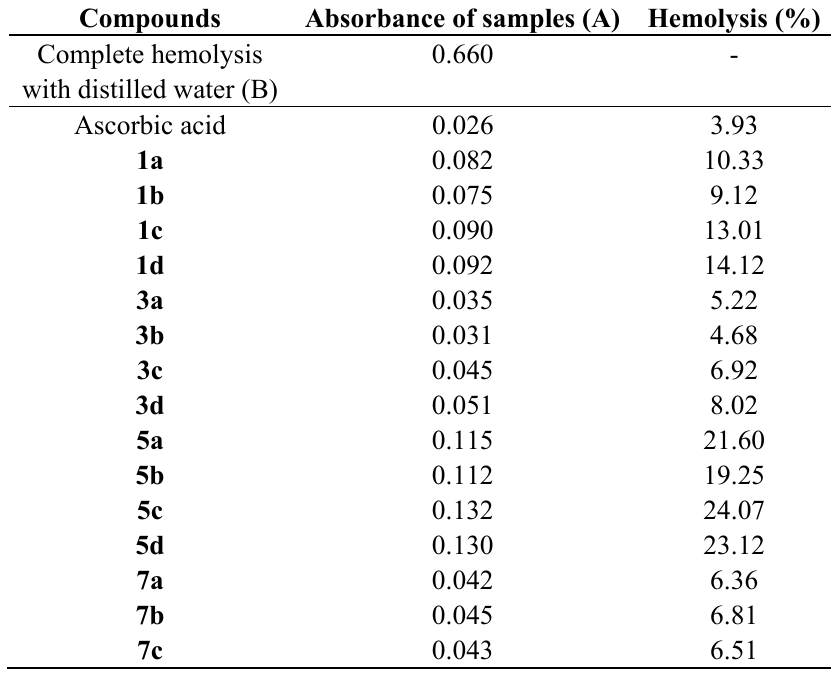
Table 2. Antioxidant assays by erythrocyte hemolysis (A/B × 100).